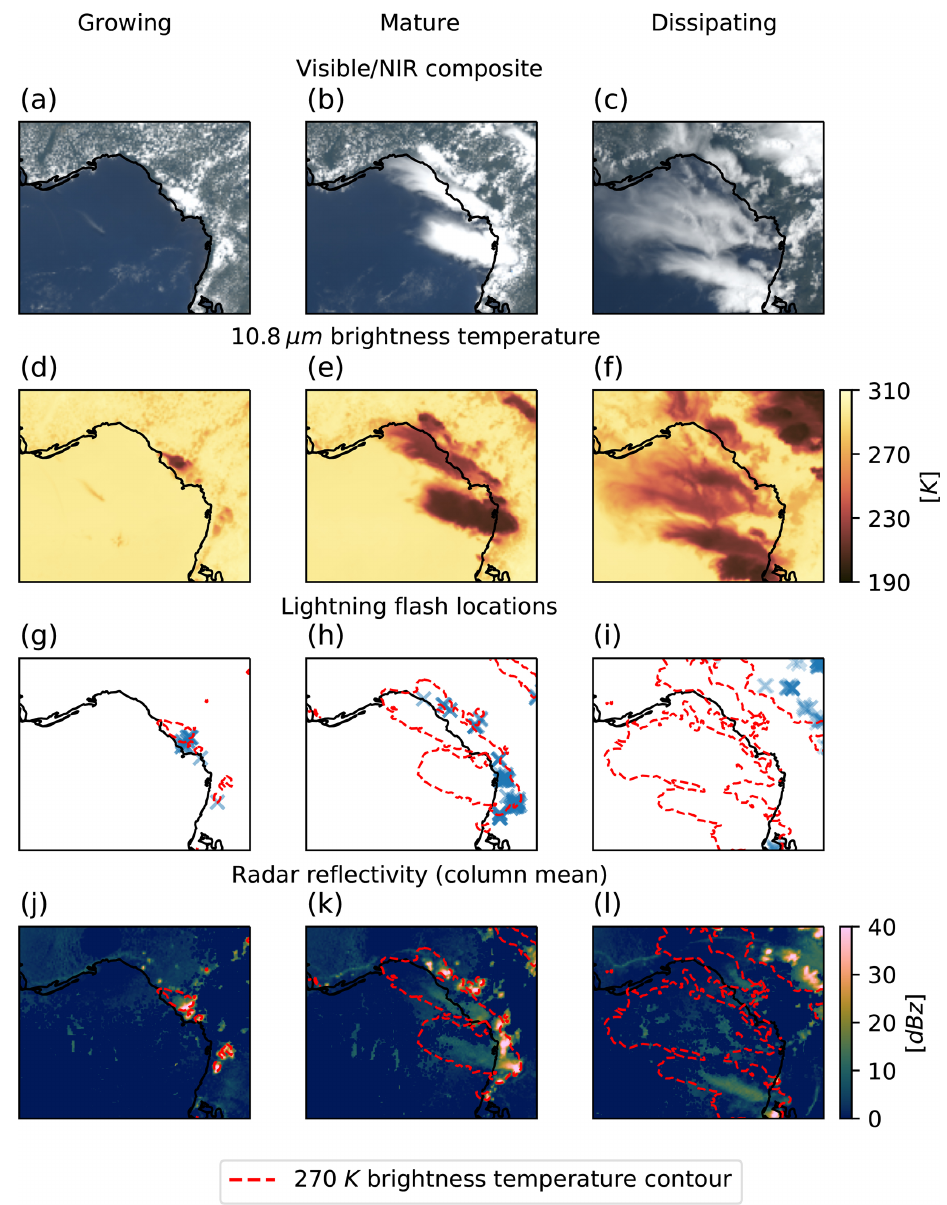
Figure 1. Observations of a cluster of deep convective clouds over north-west Florida throughout three stages of their life cycle. This cluster of DCCs occurred on the afternoon of 19 June 2018. The “growing” column were observed at 17:00UTC, the “mature” column at 19:00UTC, and the dissipating column at 21:00UTC. Note that, unless otherwise specified, this case study is used for all subsequent figures in this